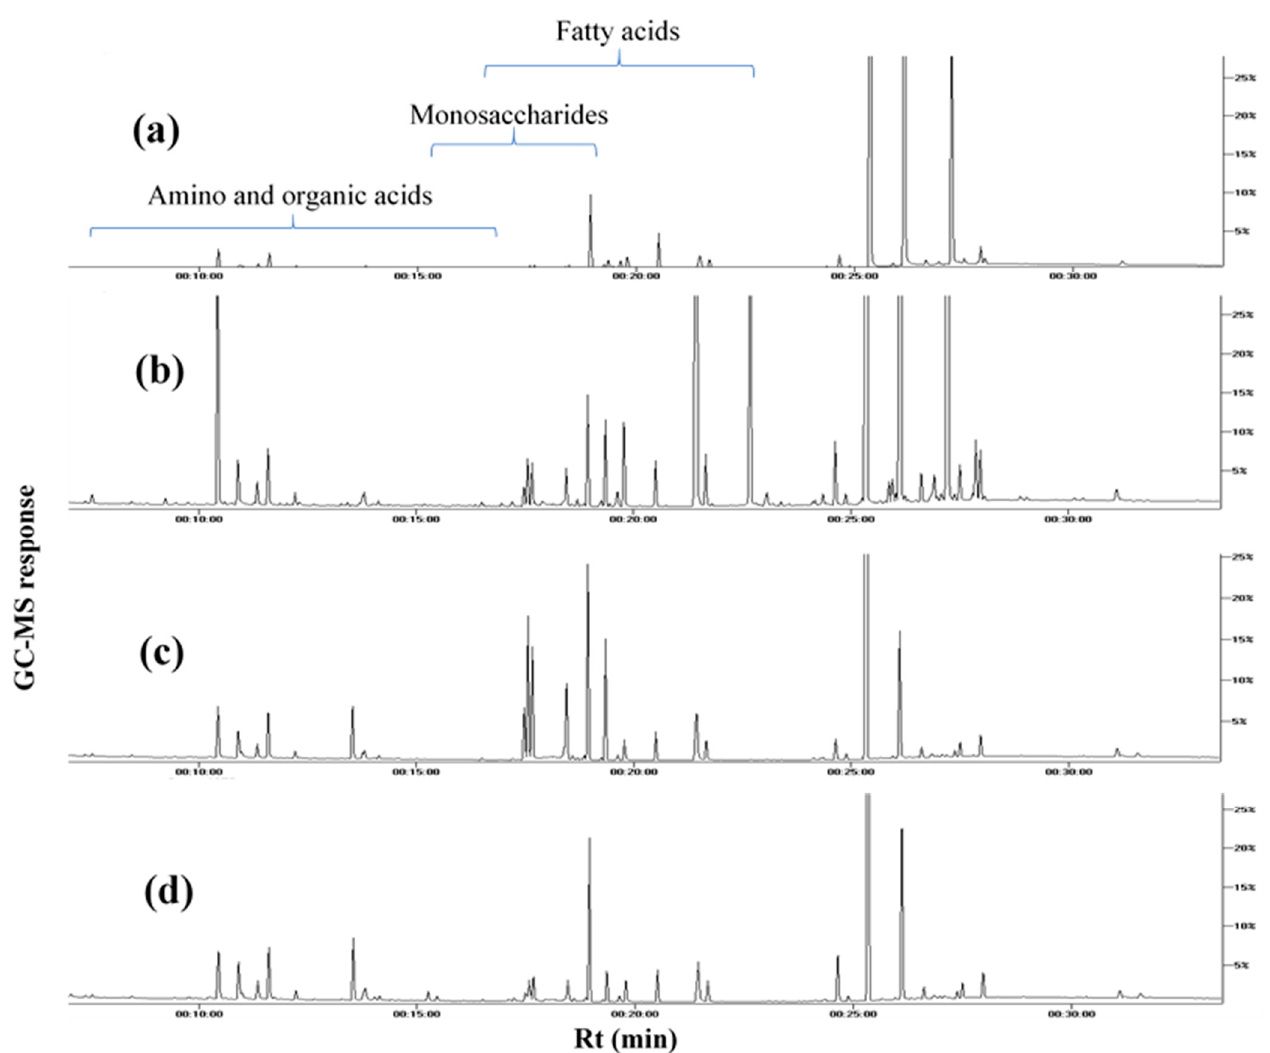
Figure 1. Representative GC–MS chromatograms of TMS derivatives of primary metabolites, collected from the extracts of ( a ) white mahlab from Greece “WG”, ( b ) white mahlab from Egypt “WE”, ( c ) red mahlab from Egypt “RE” and ( d ) roasted red mahlab from Egypt “RRE”.